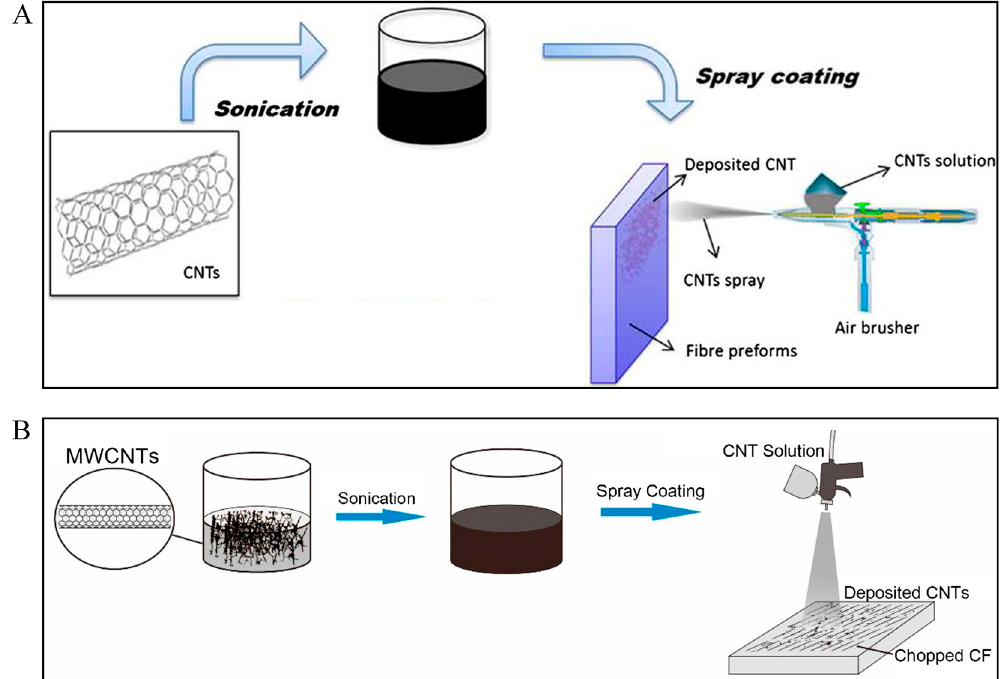
Figure 6. Schematic illustrations of CNT spray coating. ( A ) Onto CF prepreg. Reprinted with permission from ref. [121], Copyright 2014 Elsevier Ltd. ( B ) Onto chopped CFs. Reprinted with permission from ref. [32], Copyright 2019 Elsevier